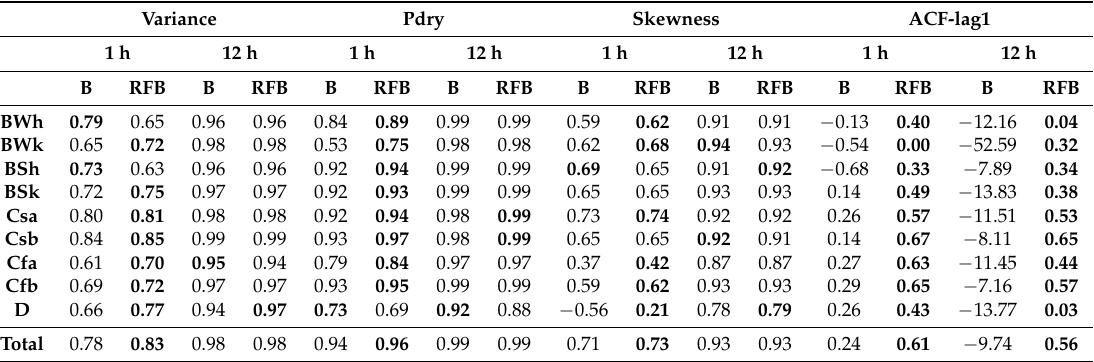
Table 2. Coefficient of determination ( R 2 ) computed through 10-fold cross-validation for the 1-h and 12-h variance, probability of a dry interval (Pdry), skewness, and lag-1 autocorrelation coefficient for Beuchat’s model (B) and for the random forests-based model (RFB) proposed in the present paper. Bold letters highlight the best performing model for every climate and